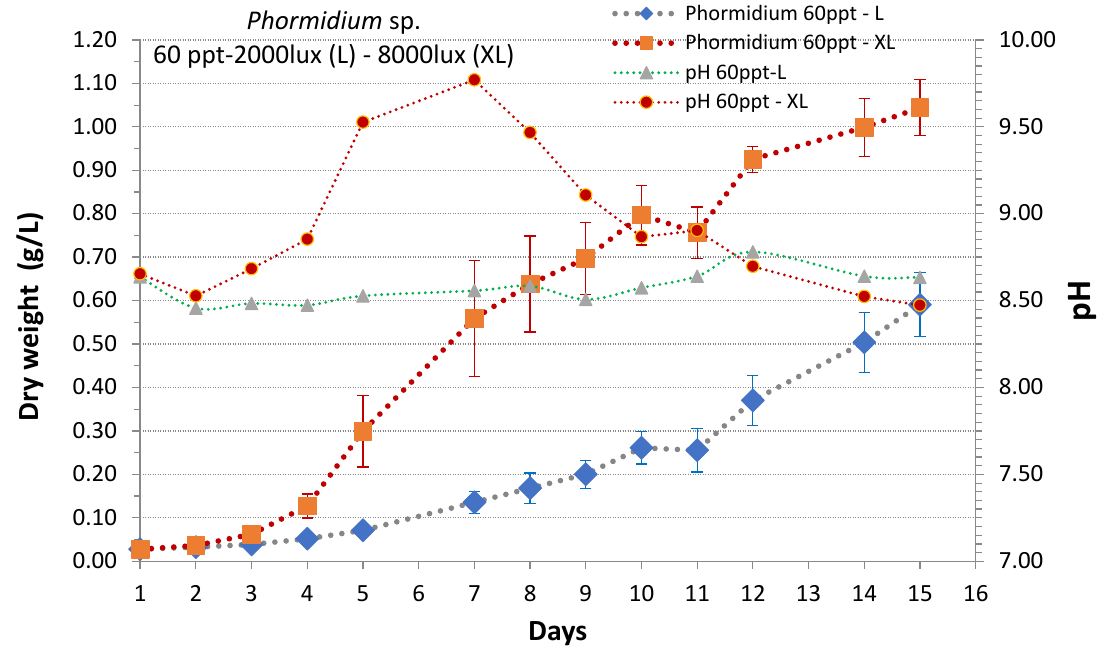
Figure 6. Growth curve and pH values for the period of a culture of Phormidium sp. at a salinity of 40 ppt in two light regimes: “high light”-“XL”-8000 lux and “low light”-“L”-2000 lux.